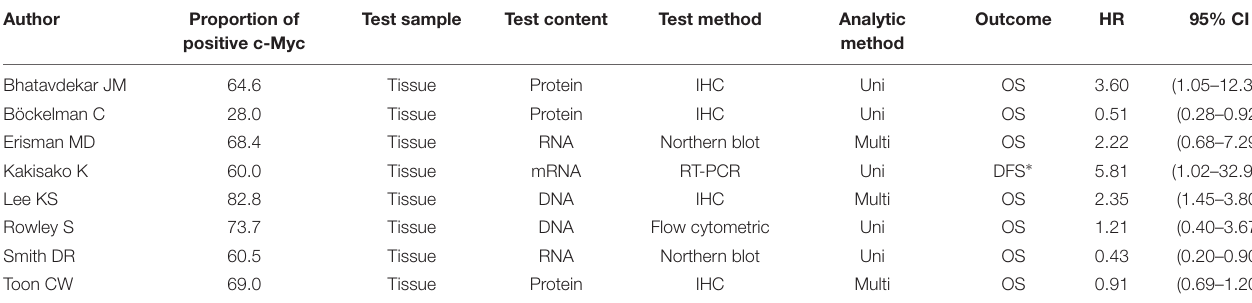
TABLE 2 | The c-Myc information and results of the included studies.